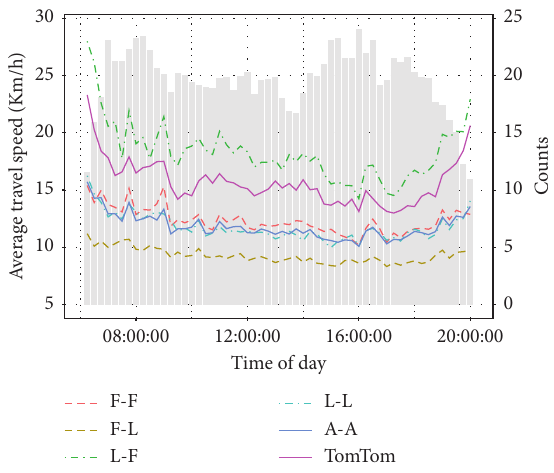
Figure 17: The comparison of five BTaverage speeds and TomTom average speed of link 906-308.